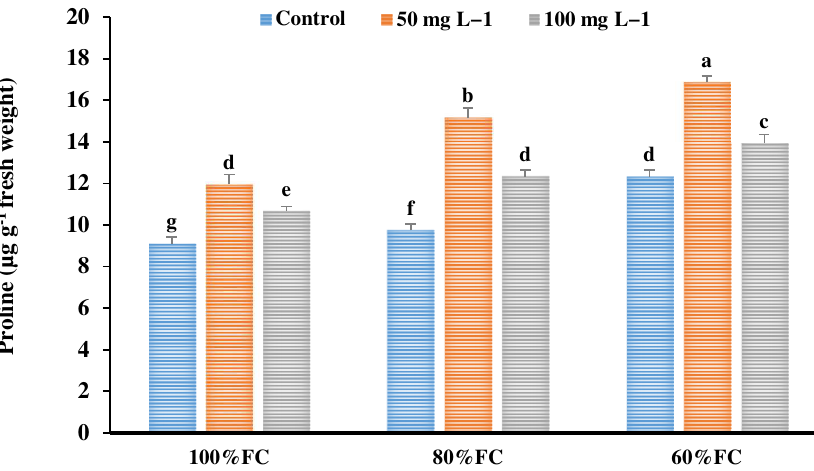
Figure 4. The proline concentration of basil in different irrigation regimes and Se NPs. Different letters indicate significant differences at the 5% level according to LSD’s test.